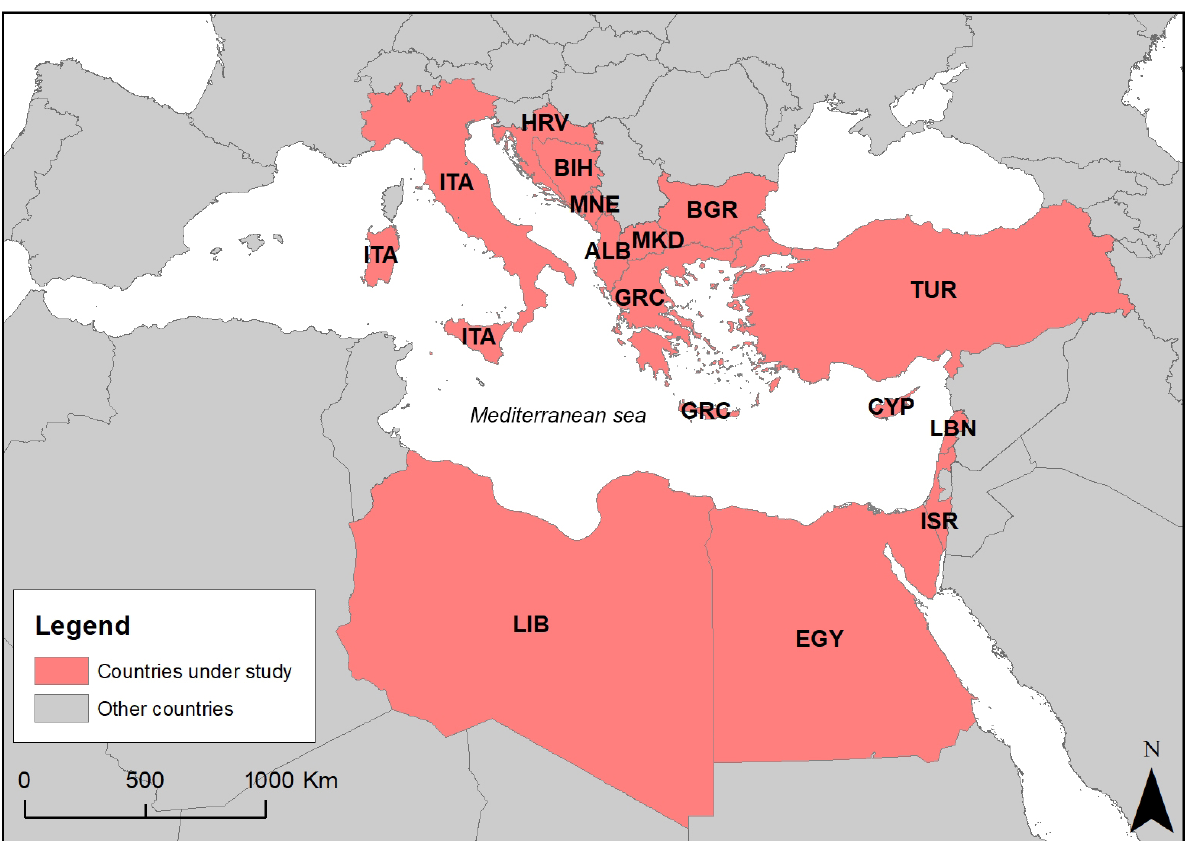
Figure 1. Map of the countries included in the database. Note the abbreviations: ALB: Albania, BIH: Bosnia and Herzegovina, BGR: Bulgaria, HRV: Croatia, CYP: Cyprus, EGY: Egypt, GRC: Greece, ISR: Israel, ITA: Italy, LBN: Lebanon, LBY: Libya, MNE: Montenegro, MKD: North Macedonia, TUR: Turkey.